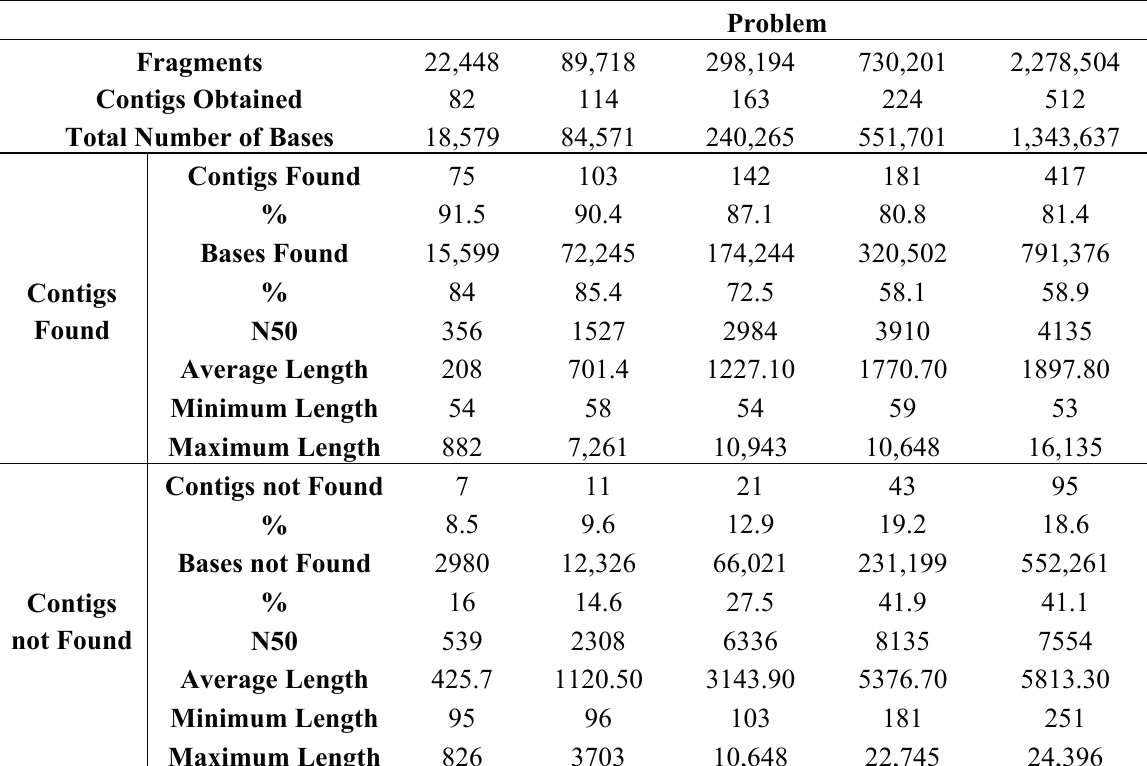
Table 9. Algorithm 1, F 2 objective function, no transitive overlaps.